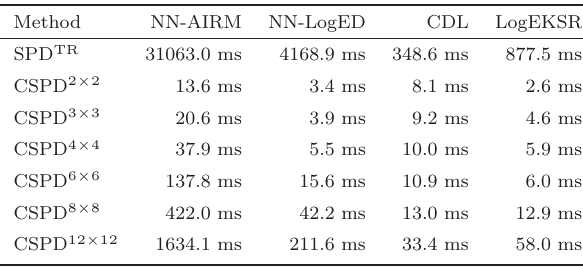
Table 7 Time taken by different data descriptors with the same classification